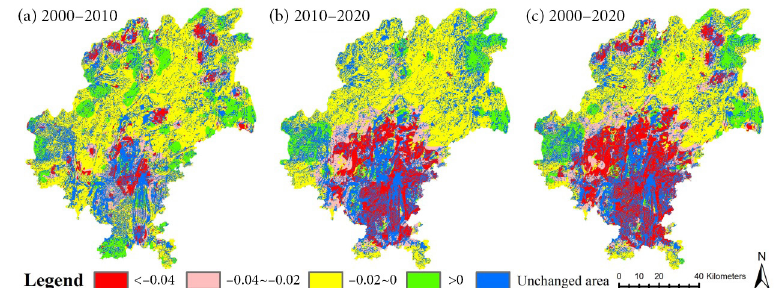
Figure 6. Spatial pattern of the habitat quality change in